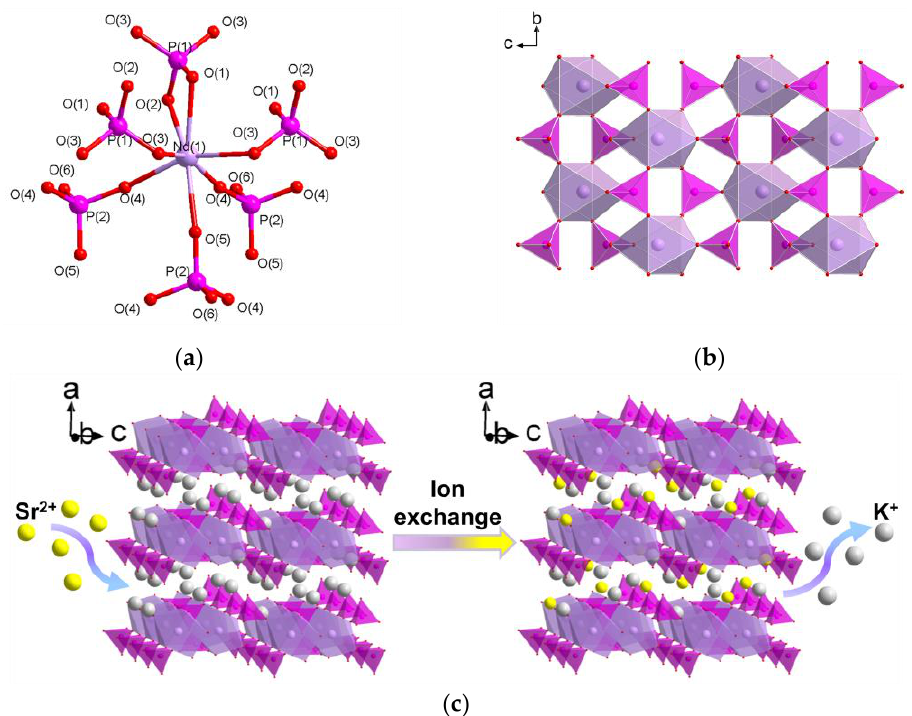
Figure 1. ( a ) Coordination of Nd 3+ ion by [PO 4 ] tetrahedra in K 3 Nd(PO 4 ) 2 ; ( b ) an anionic layer of [Nd(PO 4 ) 2 ] n 3 n − in K 3 Nd(PO 4 ) 2 ; ( c ) the schematic diagram of ion exchange between Sr 2+ and K + ions in layered K 3 Nd(PO 4 ) 2 . (The purple tetrahedra are PO 4 and the lavender polyhedra are NdO 7 ).